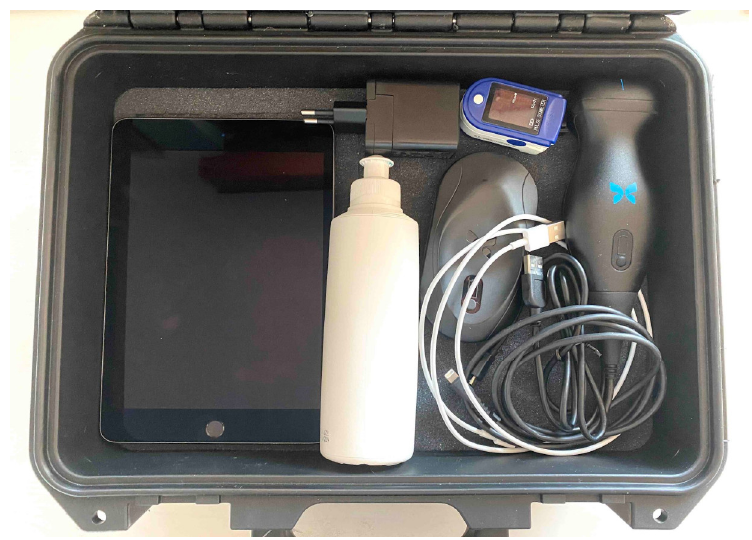
Figure 1. Home sonographic evaluation kit (see the Methods section for details).